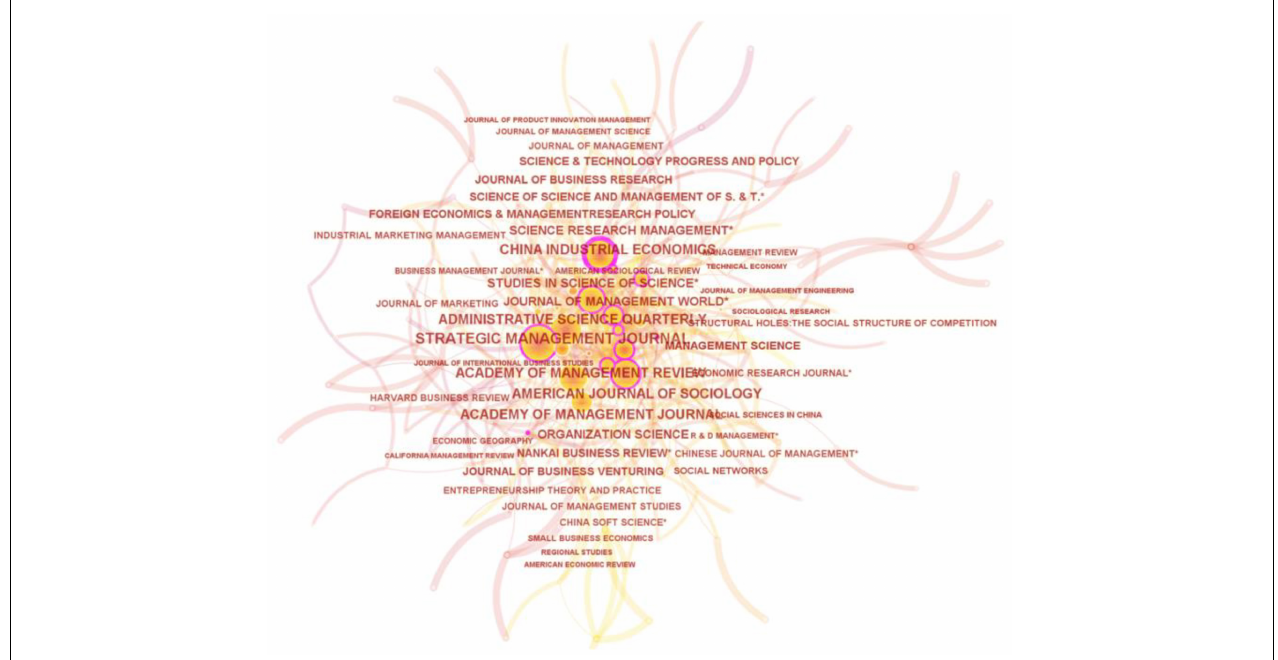
FIGURE 4 | Sources with high frequency of